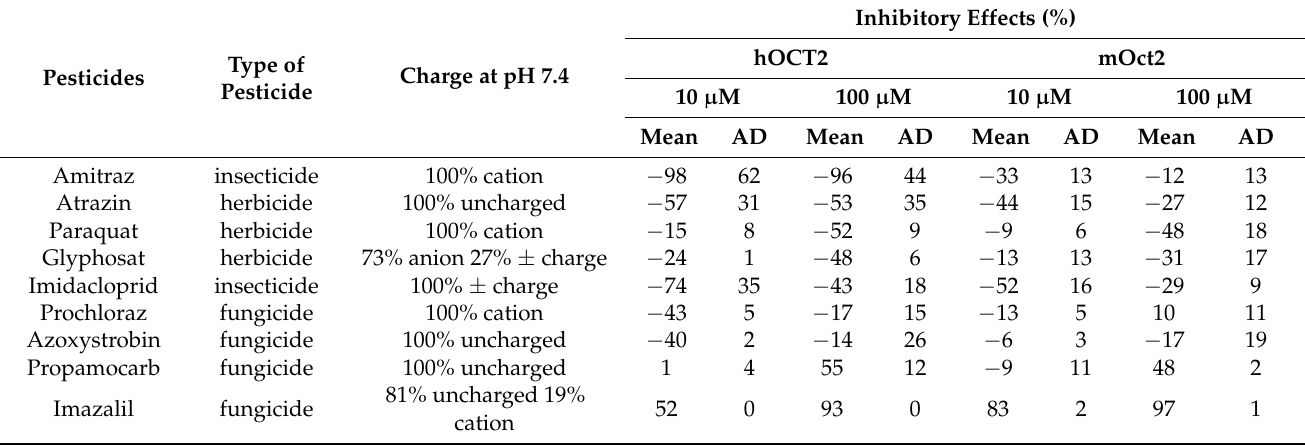
Table 2. Inhibitory effects (mean ± average deviation (AD)) of various pesticides on hOCT2- and mOct2-mediated